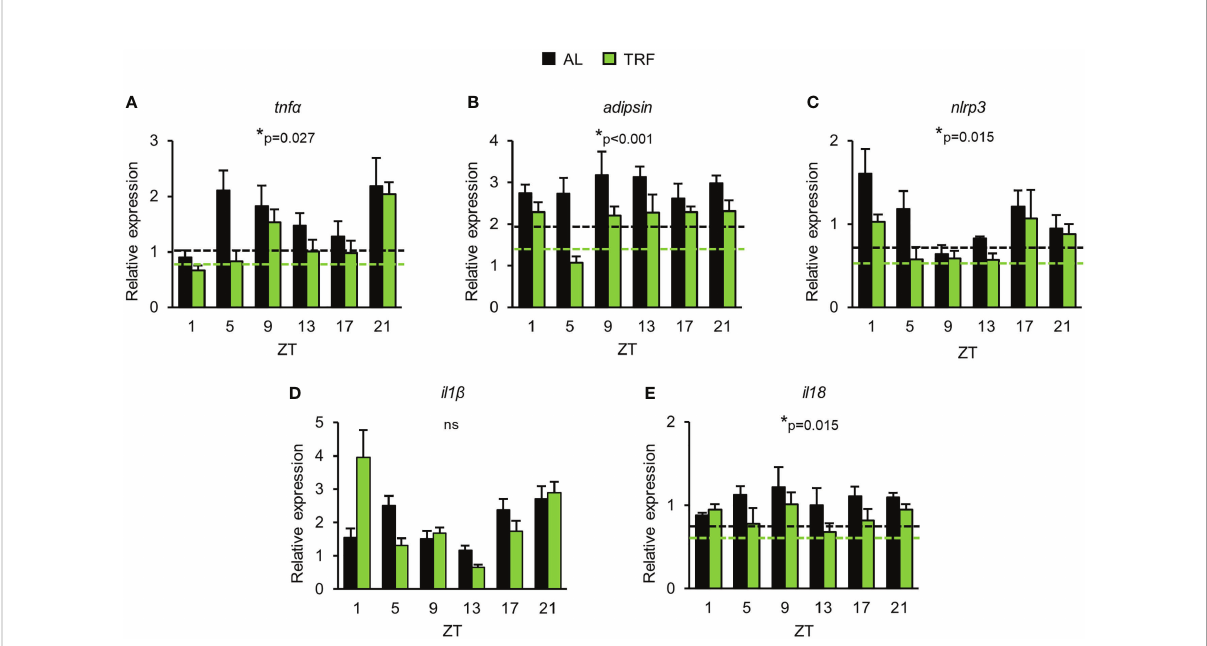
FIGURE 4 Time restricted feeding has anti-in fl ammatory effect in visceral adipose tissue. Relative mRNA expression of tnf a (A) , adipsin (B) , nlrp3 (C) , il1 b (D) and il18 (E) in the course of day in visceral adipose tissue (mean + SEM, n = 3-9 (AL), n = 6-11 (TRF), two-way ANOVA, * indicates signi fi cant group effect). Rplp0 was used as reference gene. Dashed lines indicate the average daily mRNA expression of the indicated gene, where signi fi cant group effect persists. ZT, Zeitgeber time ns, not signi fi